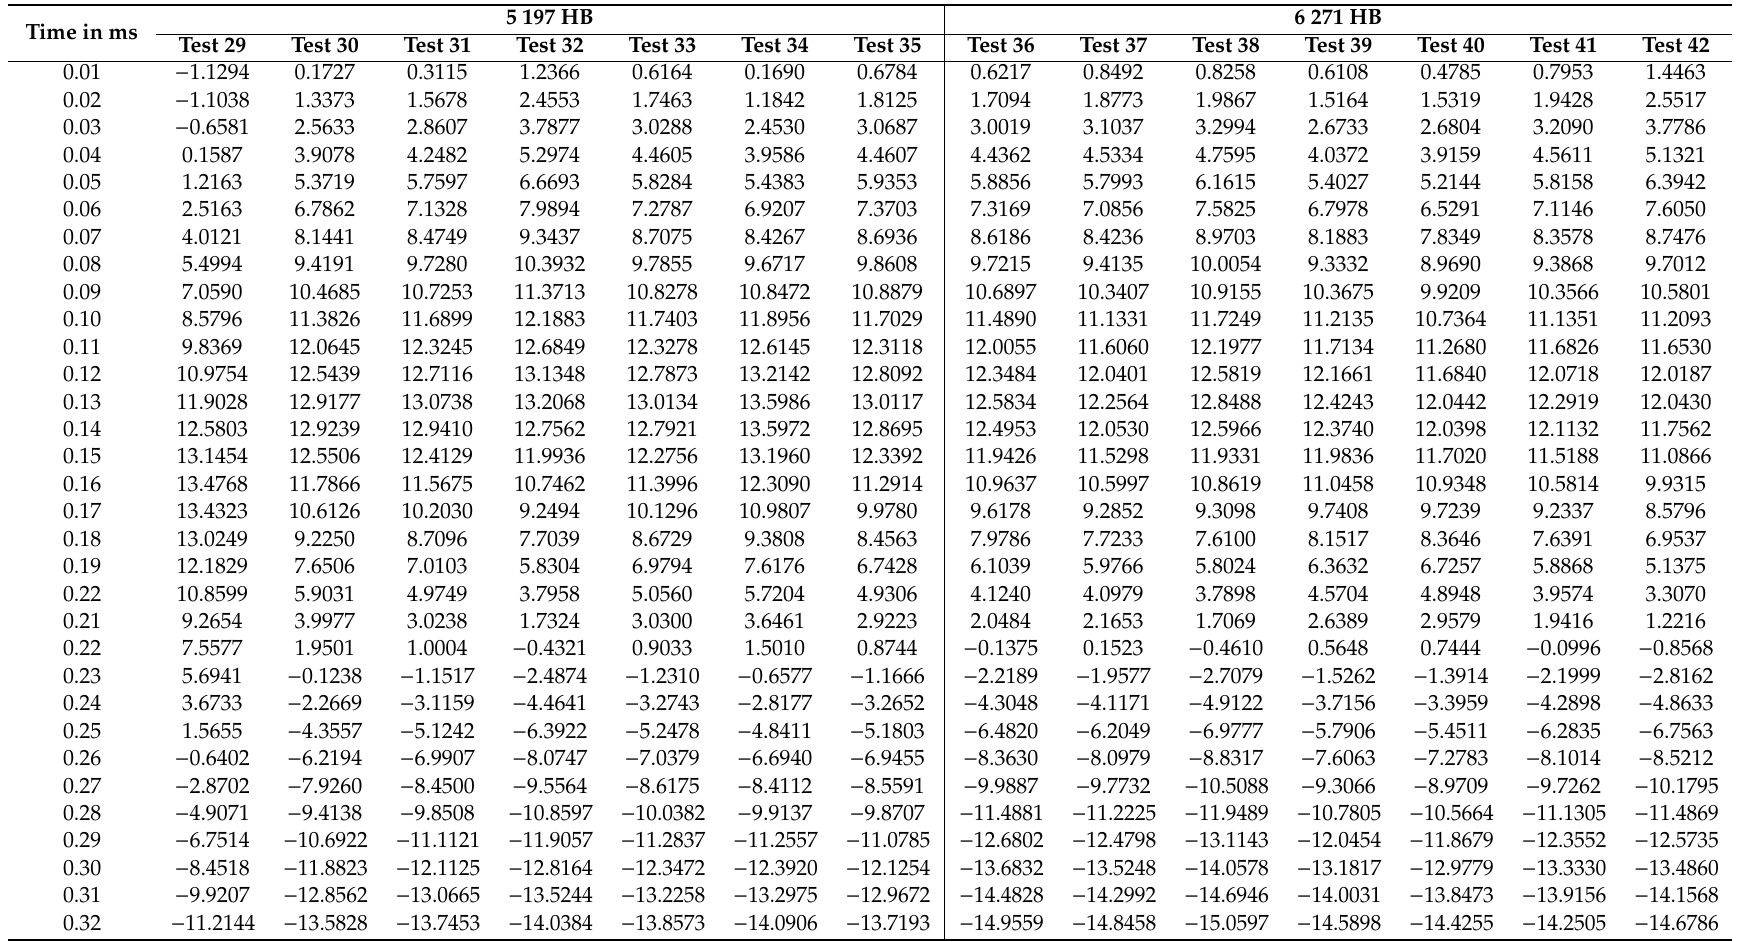
Table A3. Accelerations measured for tests from 29 to